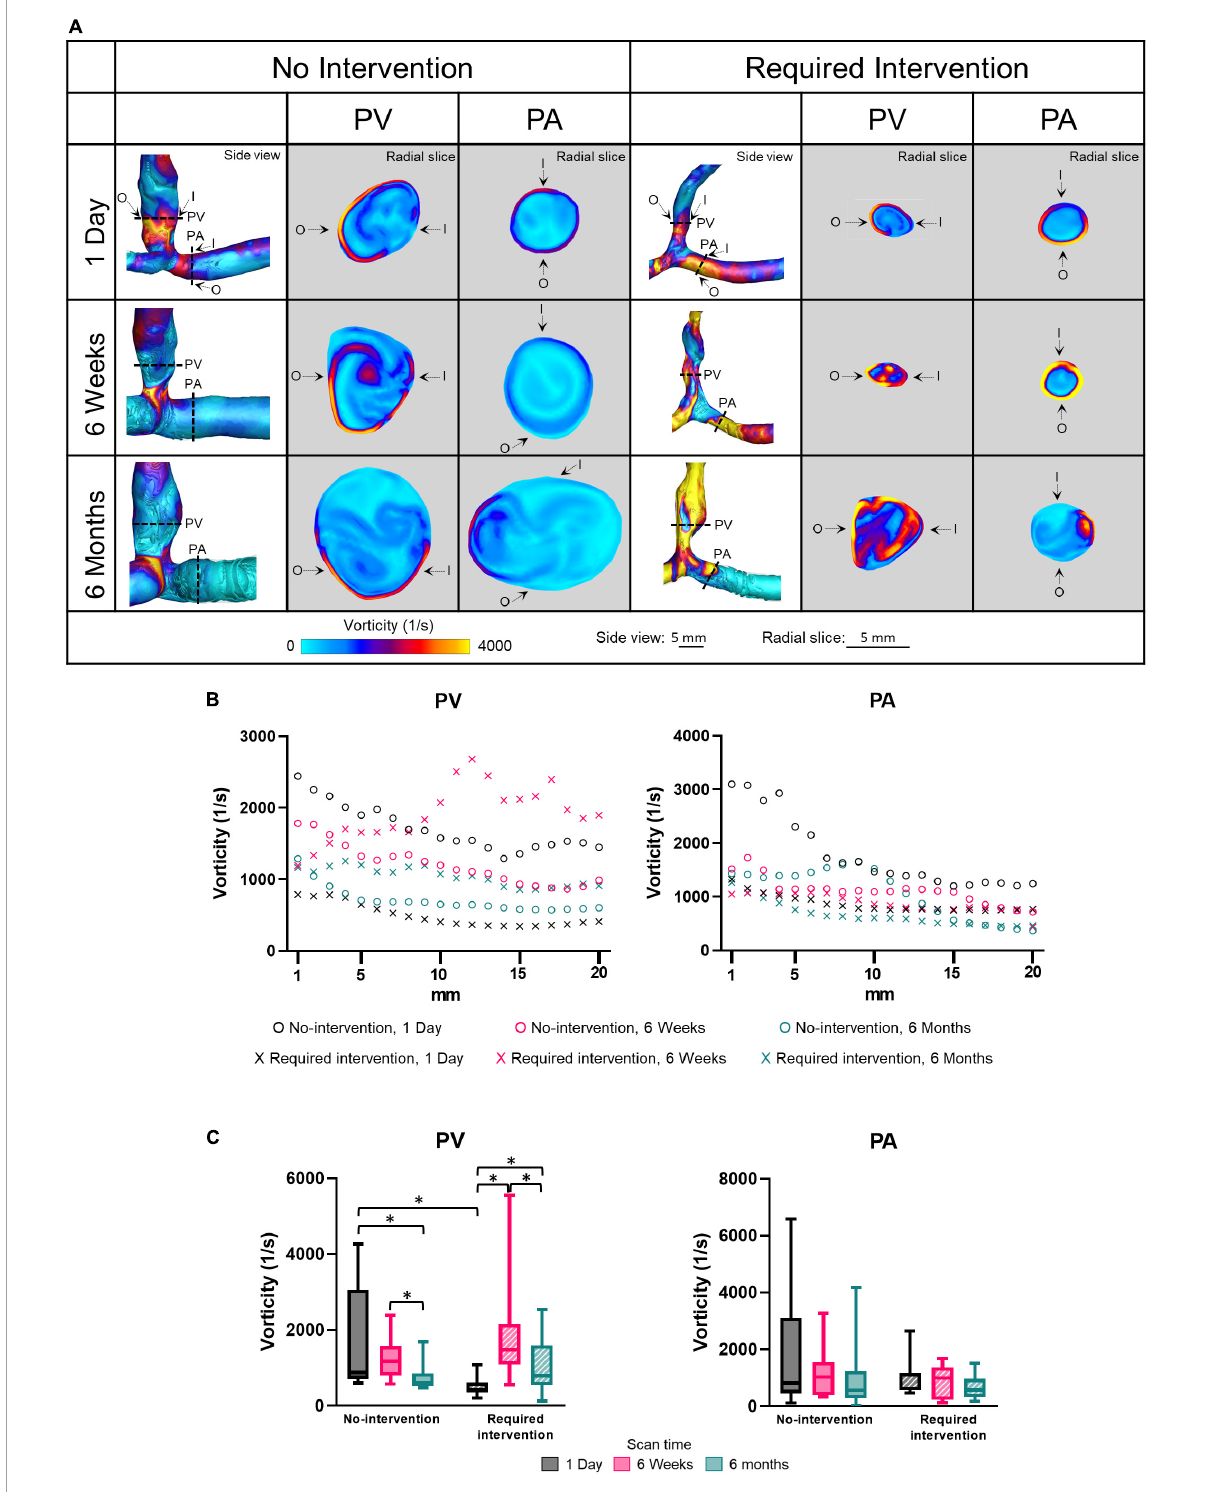
FIGURE6 Vorticity of the proximal vein (PV) and proximal artery (PA). (A) The side view and radial slices of vorticity color maps of representative arteriovenous fistulas at systole. Dotted lines in the side view color maps show the location of radial slices, approximately 5 mm from the anastomosis. O and I denote the locations of outer and inner walls, respectively. (B,C) Show vorticity for the "no intervention" and "required intervention" groups at 1 day, 6 weeks, and 6 months, as explained in Figure 2 . ∗ P <